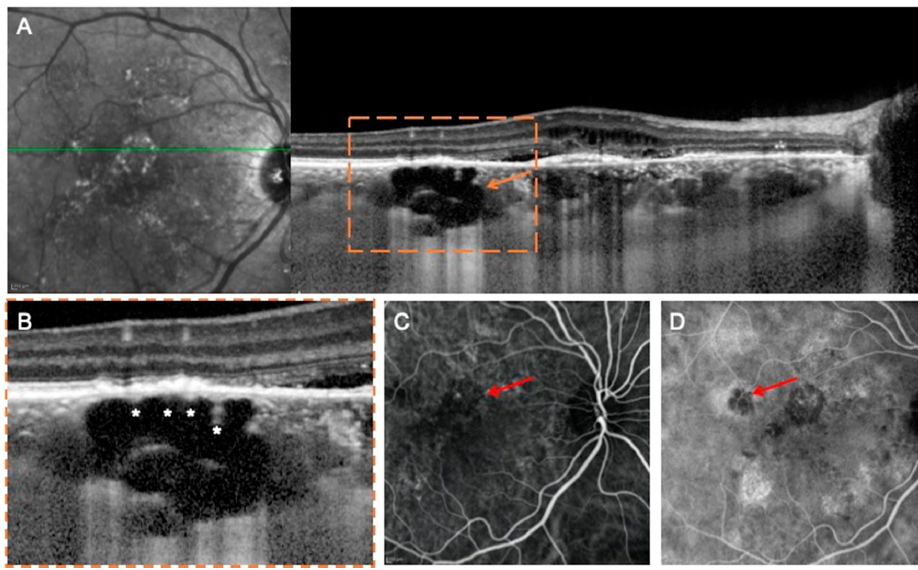
Figure 1. Multimodal imaging of a choroidal rift in a case of chronic central serous chorioretinopathy (CSC). ( A ) Optical coherence tomography (OCT) B-scan and relative IR image with the